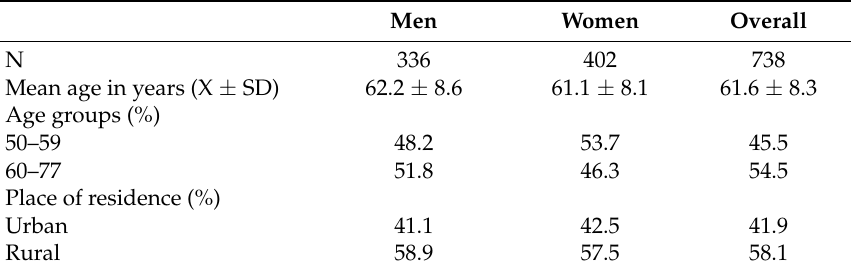
Table 1. Socio-demographic characteristics of the